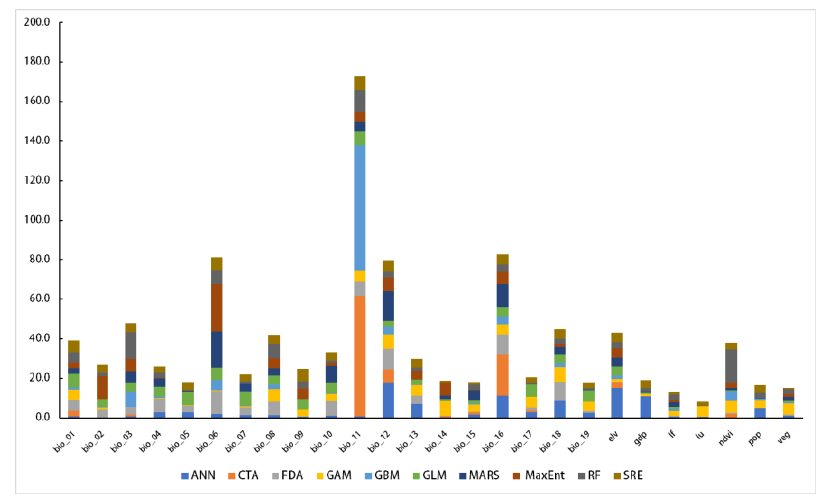
Figure 4. Contributions of environmental variables to ten ecological niche models.